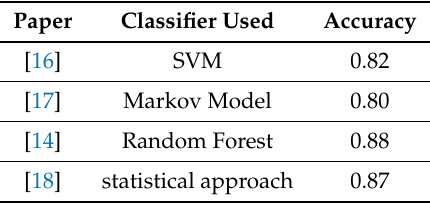
Table 10. A summary of the state-of-the-art precision metrics for IMDb, where SVM: Support Vector